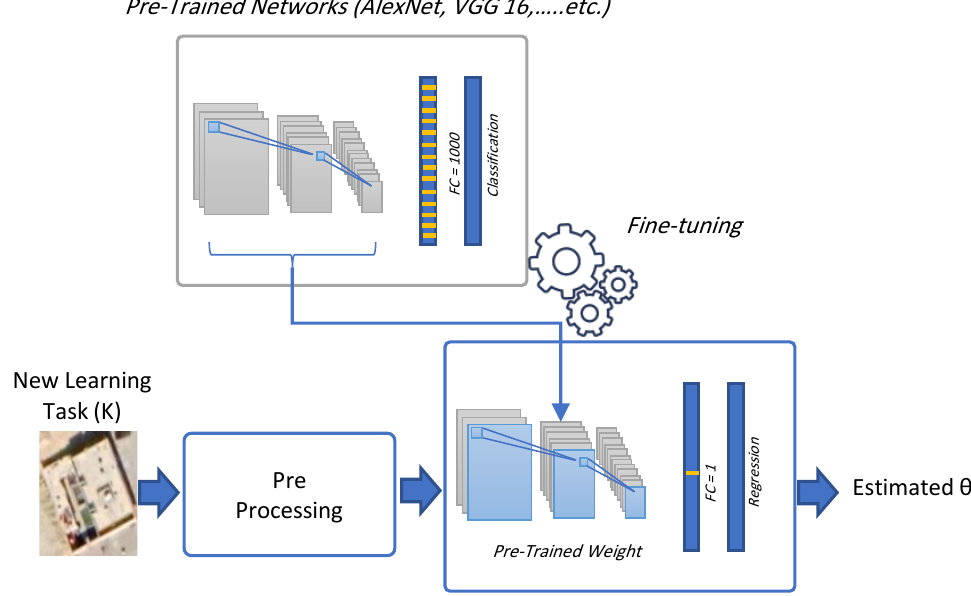
Figure 3. The first proposed approach based on transfer learning for building orientation angle